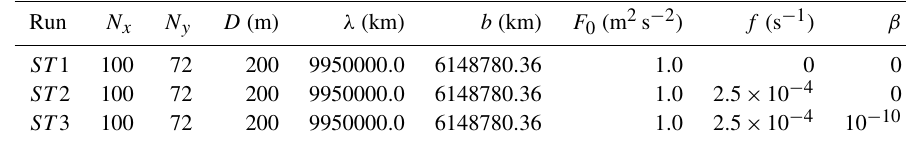
Table B1. Simulation parameters for the Stommel test case on a planar ocean basin.